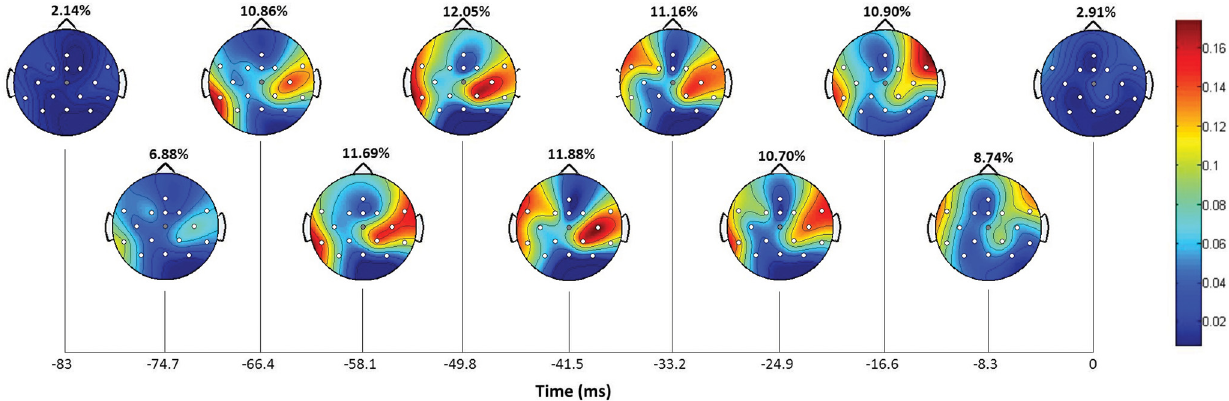
Fig 7. Contribution of the 16 recorded electrodes to the decoding performance for Subject 4, right arm (in gray, Cz electrode). The scalp maps are computed for each time lag (around 8.3 ms) and show parietal and strong central involvement. The relative contribution (%) for each lag is also computed showing a peak around 50 ms prior to the decoded instant corresponding to a 12.05% contribution. The remaining subjects show a similar